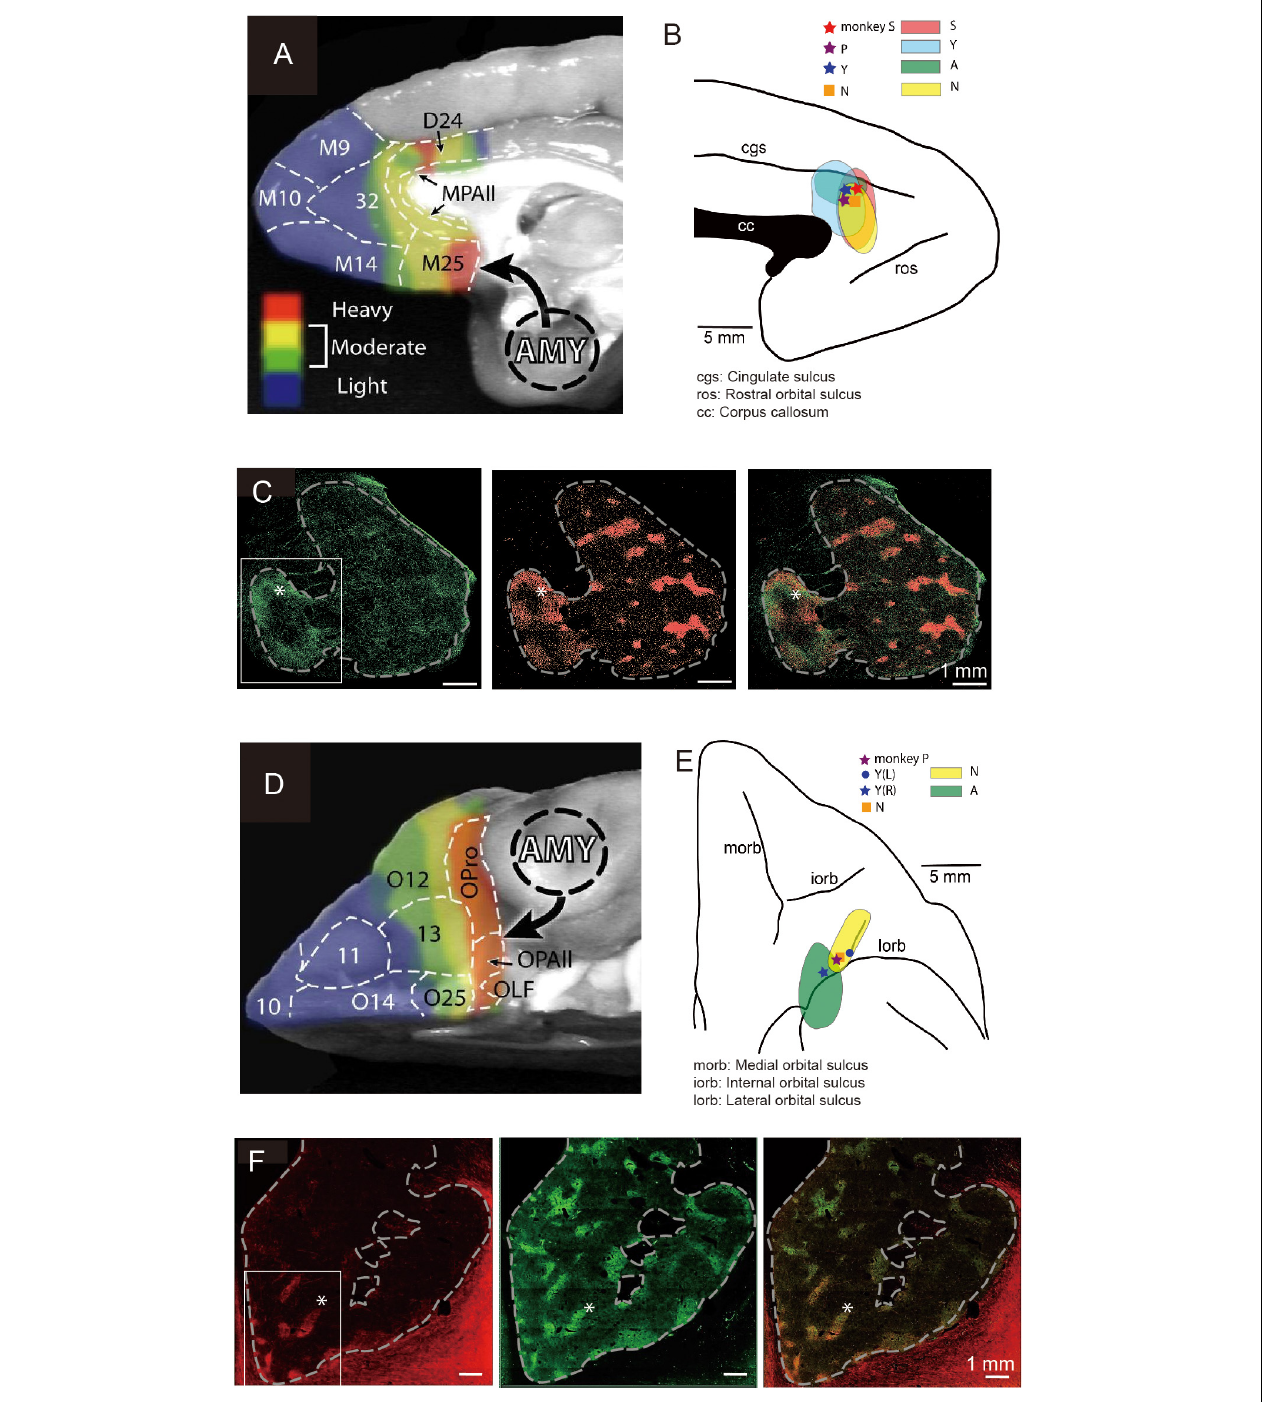
FIGURE 4 | Local sites of primate pACC and cOFC that project to the striosome compartment of the striatum causally involved in pessimistic decision-making (Modified from Amemori et al., 2020). (A) Primate pACC and sACC receive direct projection from the amygdala (Adapted from Ghashghaei et al., 2007). (B) Viral tracer was injected into a local region of the pACC (left) where avoidance behaviors were induced by electrical stimulation. (C) (Left) Projection to the striatum from the pACC local site that had a stimulating effect. (Middle) Striosomes shown by KChIP1 staining. (Right) Overlay between left and middle images. (D) Primate cOFC receives direct projection from the amygdala (AMY) (Adapted from Ghashghaei et al., 2007). (E) Viral tracer was injected into a local region where avoidance behaviors were induced by electrical stimulation of cOFC. (F) (Left) Projection to the striatum from the cOFC local site that had a stimulating effect. (Middle) Striosomes shown by KChIP1 staining. (Right) Overlay between left and middle images. The projection to striosomes was dominant.